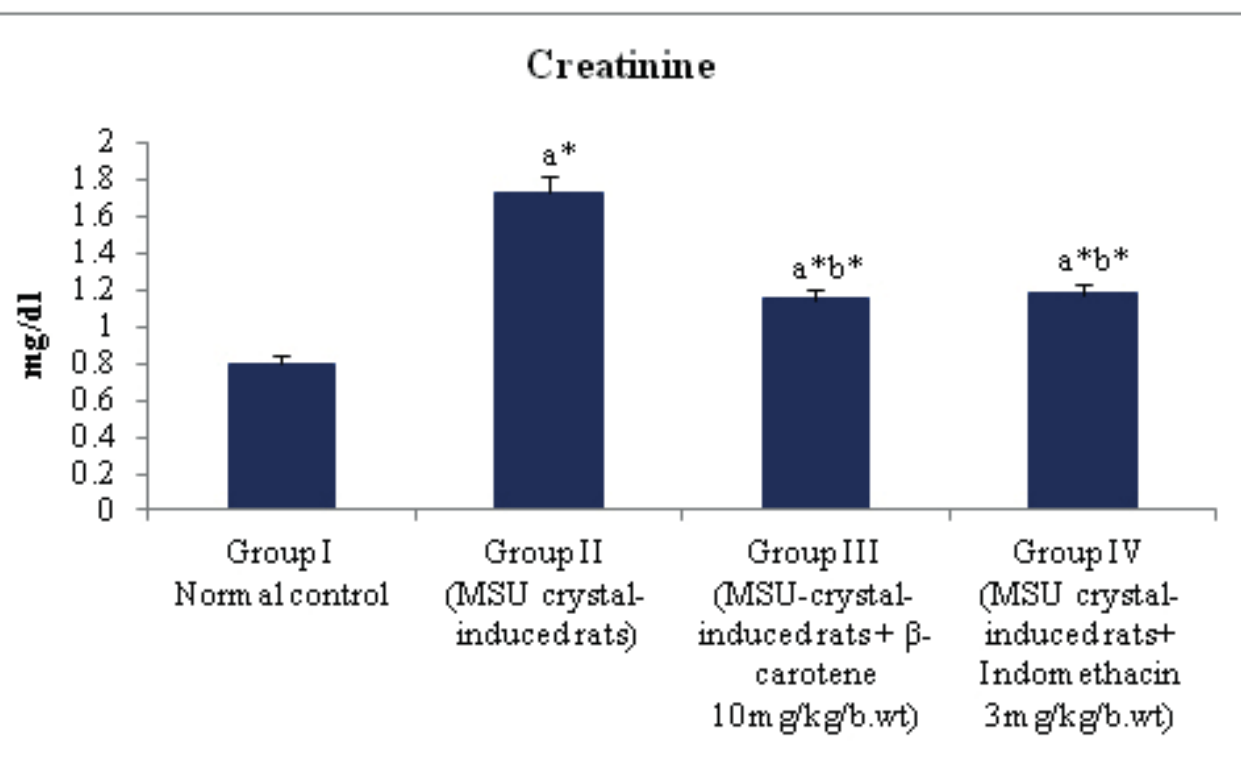
FIGURE 4 - Effect of β -carotene on serum creatinine in MSU crystal-induced arthritis N=6 animals in each group. The values are expressed as mean ± S.D. Comparisons indicated by lower case letters were made as follows: a – group I vs. group II, III and IV; b – group II vs. group III and IV; c – group III vs. group IV. Statistical analysis was carried out by one way ANOVA followed by Student’s Newman – Kuel’s test. The symbols represent statistical significance at: * p <